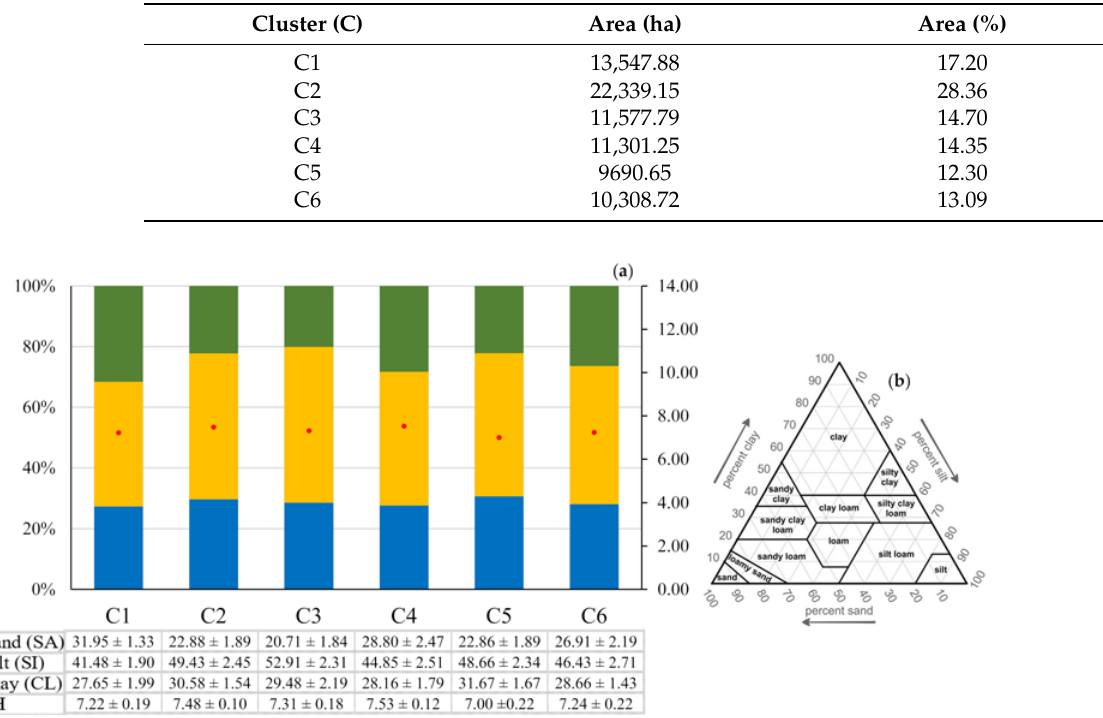
Figure 12. Significance of differences between the cluster mean percentages of SA , SI , and CL content. Red and green cells show not significant and significant difference values.